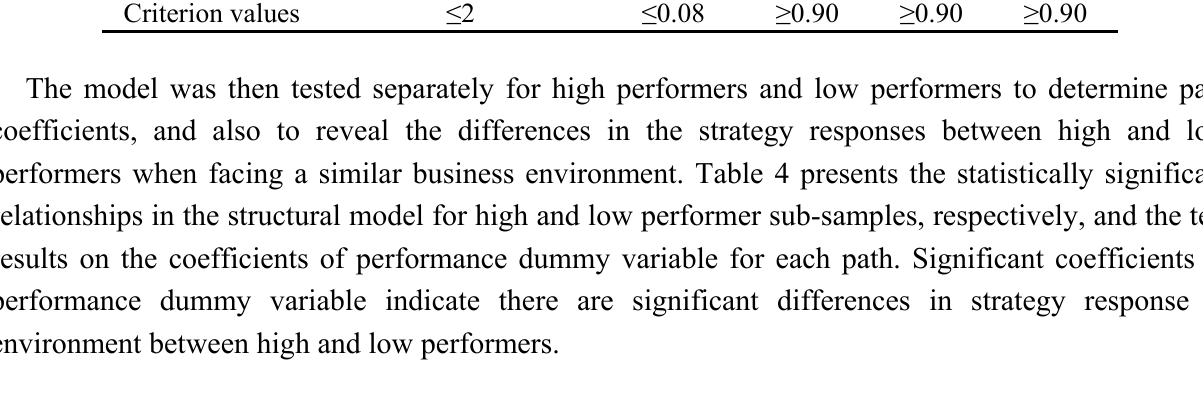
Table 4. Results of SEM analysis for the structural